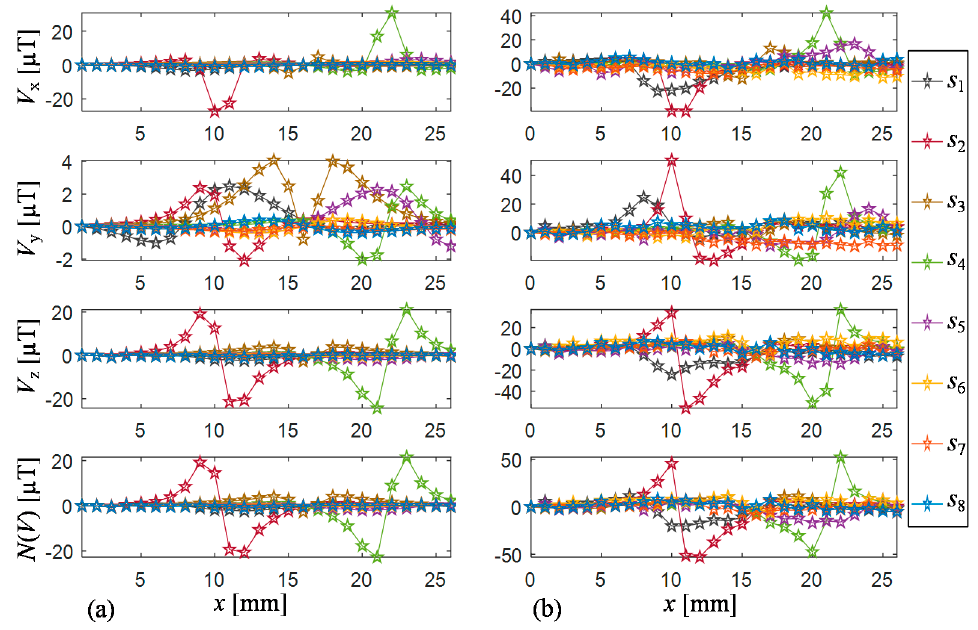
Figure 6. Comparison of selected results of magnetic field vector components acquired by all sensors for 1D scan along the 100% defect aligned at 0° to scanning direction obtained during FEM numerical simulations ( a ) and measurements ( b ).